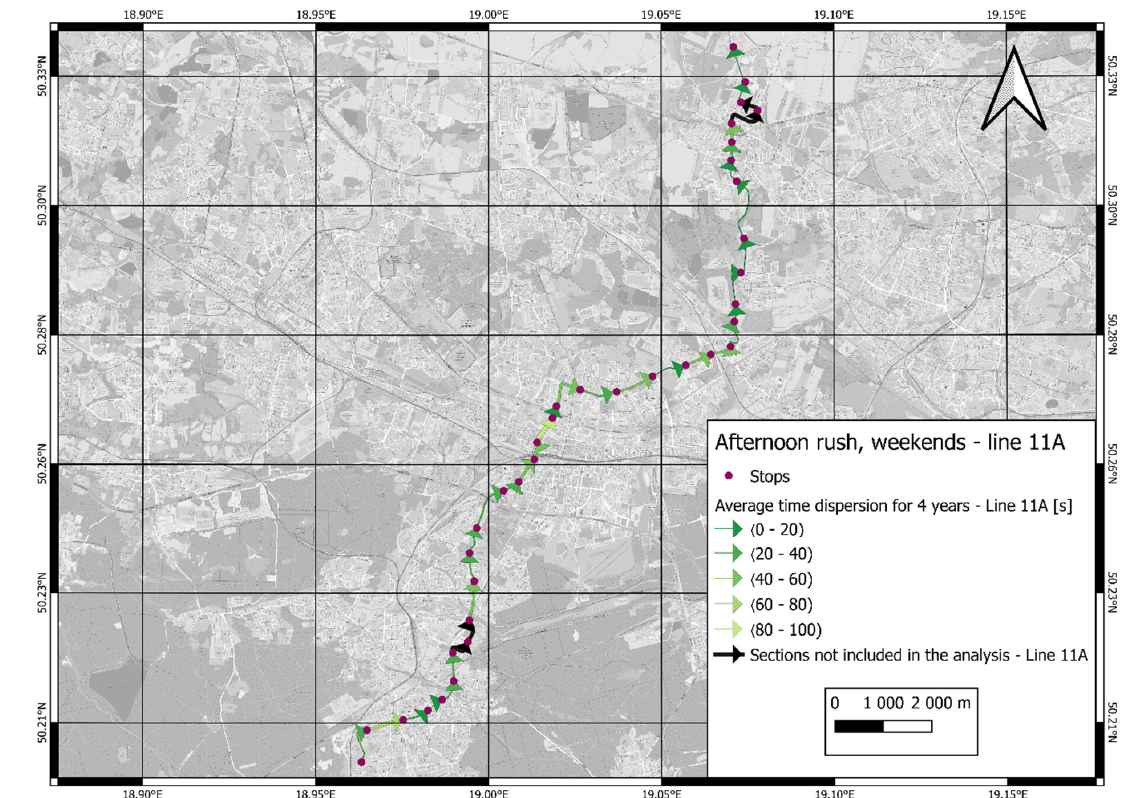
(cid:16) (cid:17) is idj values broken down into line directions, traffic